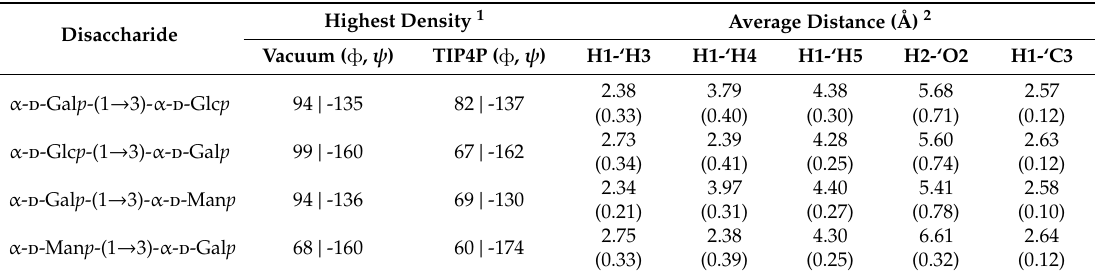
Table 3. Highest-density ( ф , ψ ) points on the Ramachandran energy maps in vacuum averaged over 1 µ s of trajectory simulation time and over 100 ns of simulation time in explicit TIP4P solvent at 300 K, and the NMR-relevant inter-residue distances averaged over the solution simulations, for all of the linkages found in the Epol H111-INS repeating